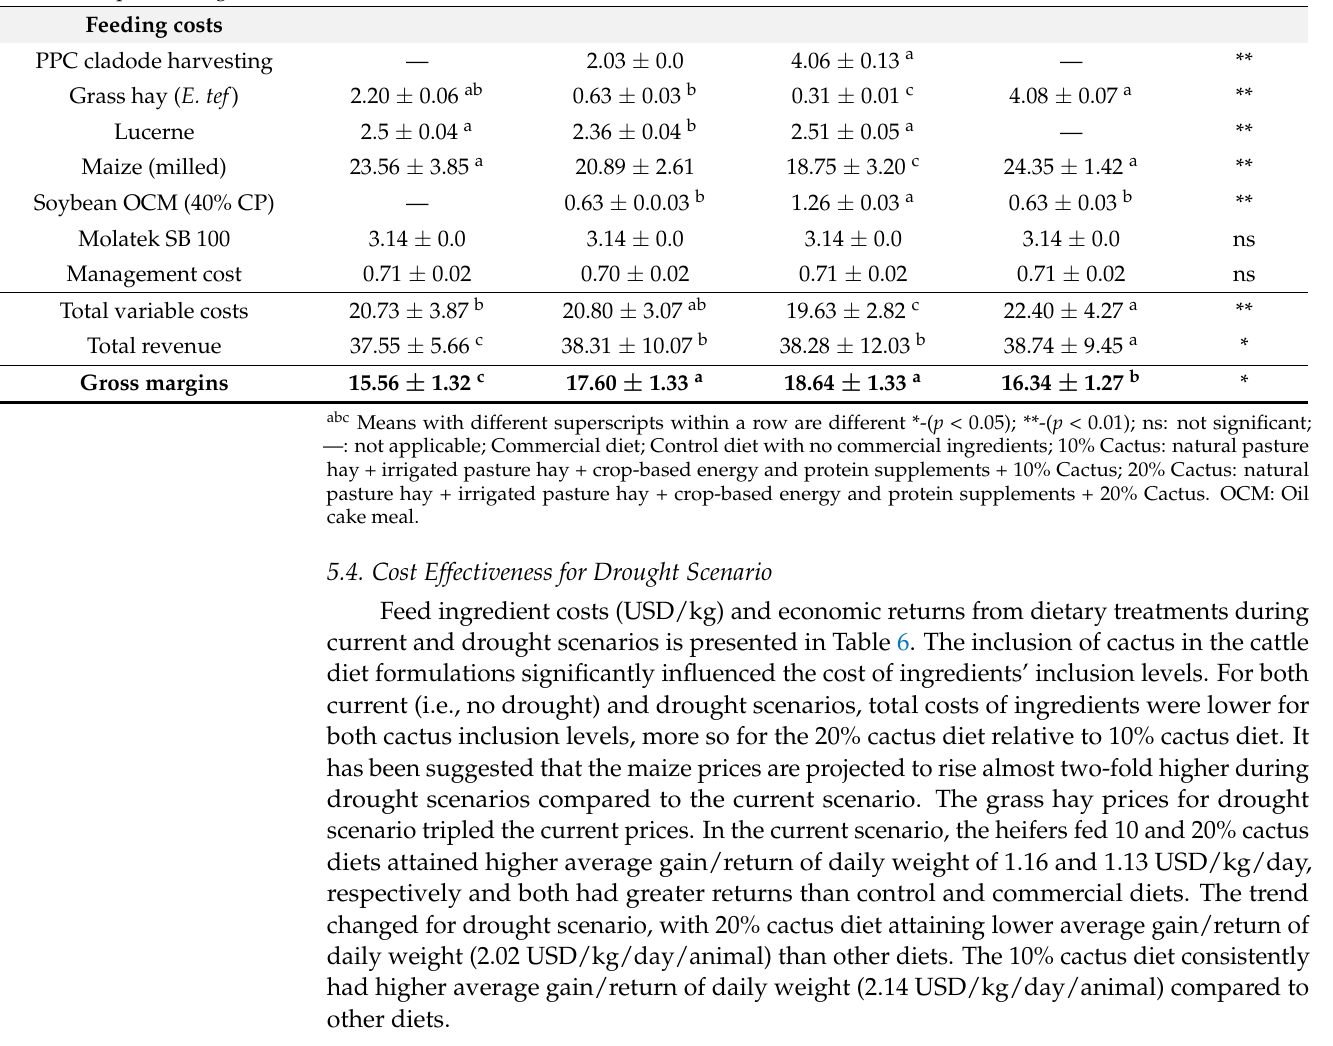
Table 6. Projected feed ingredient costs (USD/kg) and economic returns from cactus diets for current and drought